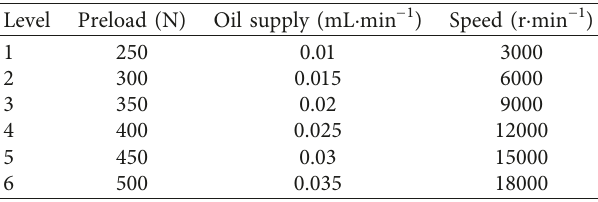
Figure 1: Motorised spindle and FCB. Table 3: Test parameters and levels.